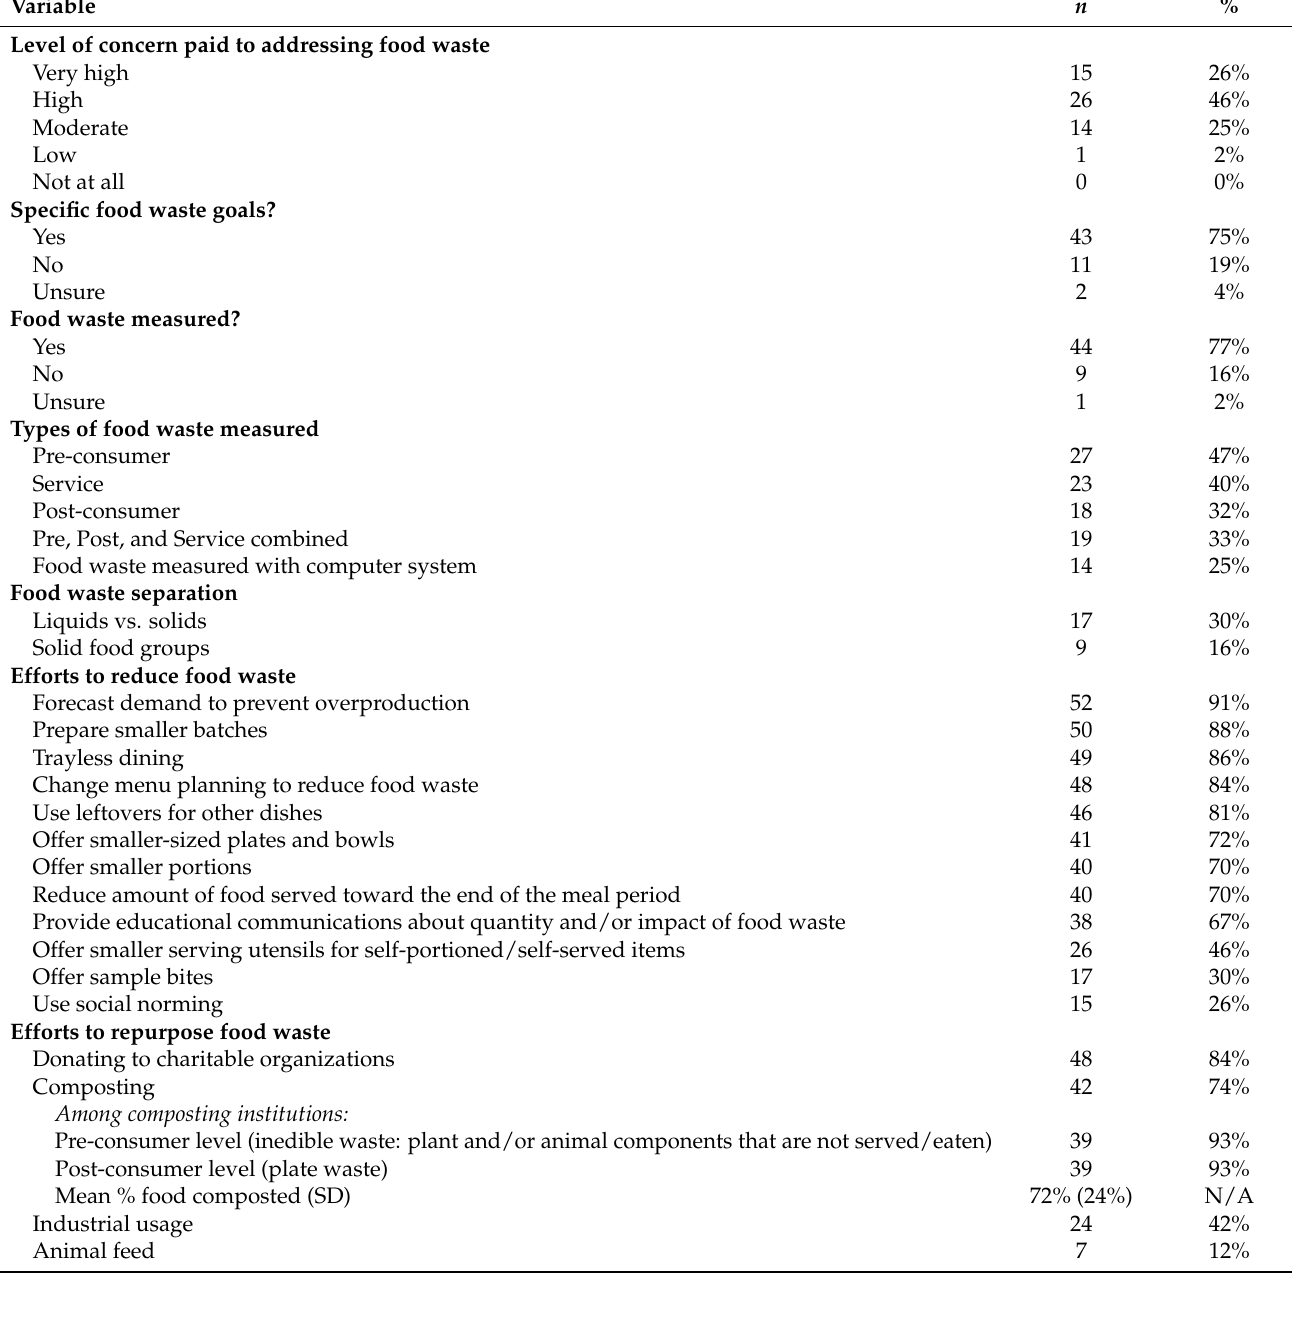
Table 2. Food-waste concern, measurement, reduction efforts, and barriers to reduction among sampled institutions ( n =